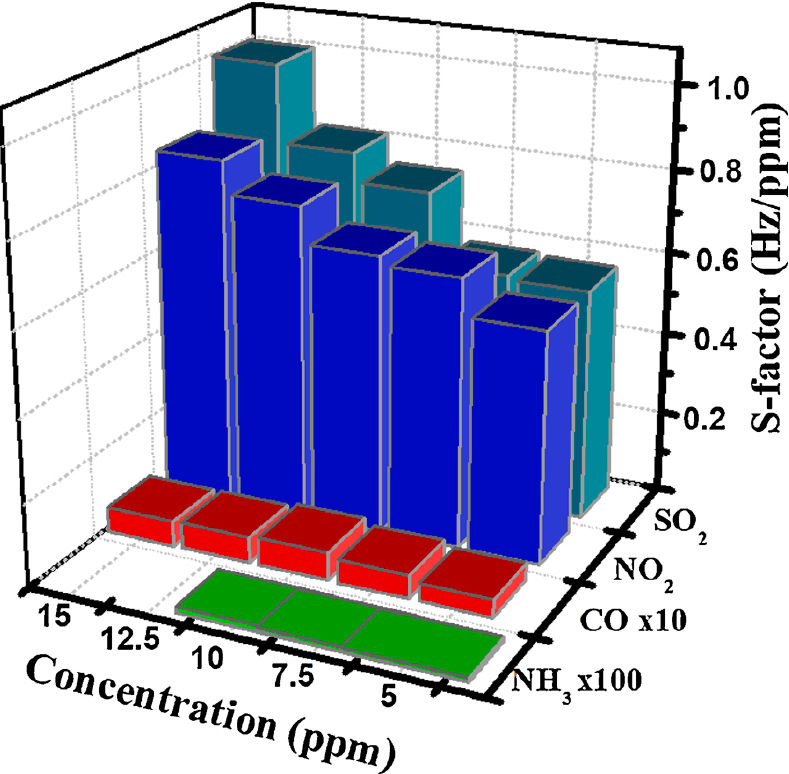
Figure 4. The sensitive factors (S-factor) of SO 2 , NO 2 , CO and NH 3 at different concentrations.